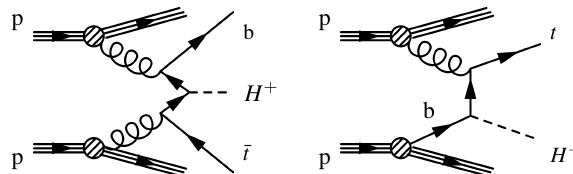
Figure 1 . Feynman diagrams for the production of a heavy charged Higgs boson in the four-(cid:13)avor scheme (4FS, left) and in the (cid:12)ve-(cid:13)avor scheme (5FS, right). the ratio of the vacuum expectation values of the neutral components of the two Higgs doublets (tan (cid:12)